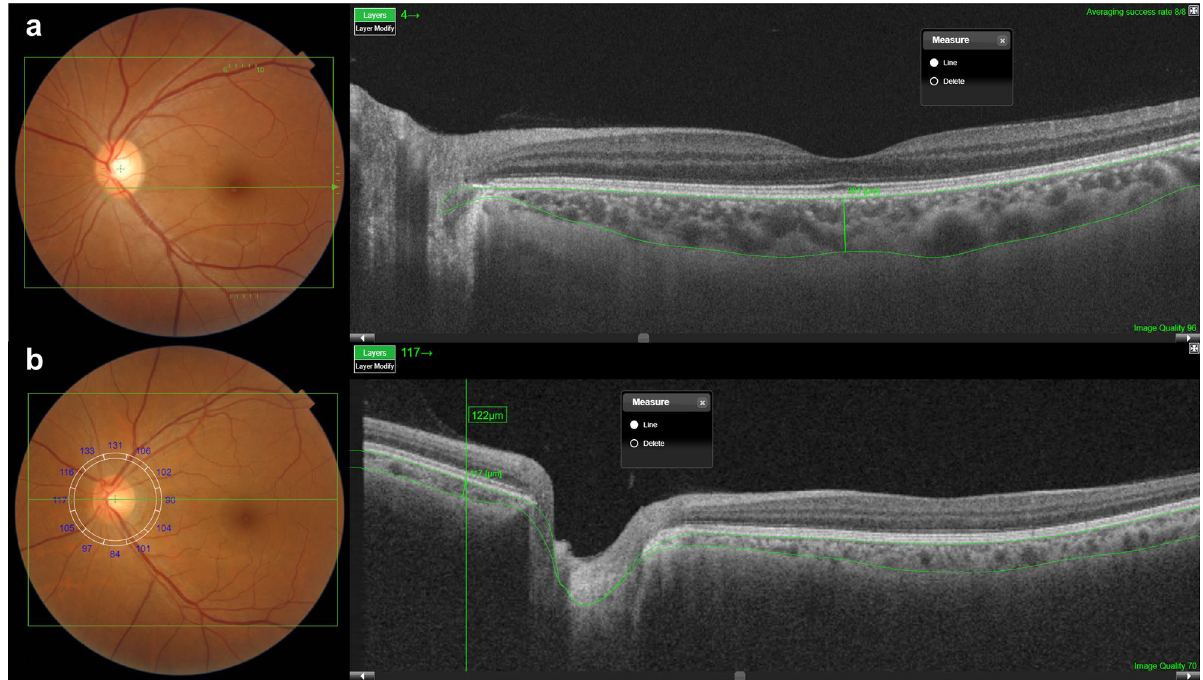
Figure 4. The methods for subfoveal and peripapillary choroidal thickness (CT) measurements. ( a ) Subfoveal CT was measured from a 9-mm line scan, which was centered on the fovea and averaged 96 B-scans to improve the signal-to-noise ratio. ( b ) Peripapillary CT was measured from a 12-mm by a 9-mm volume scan image, which was centered between the fovea and the optic